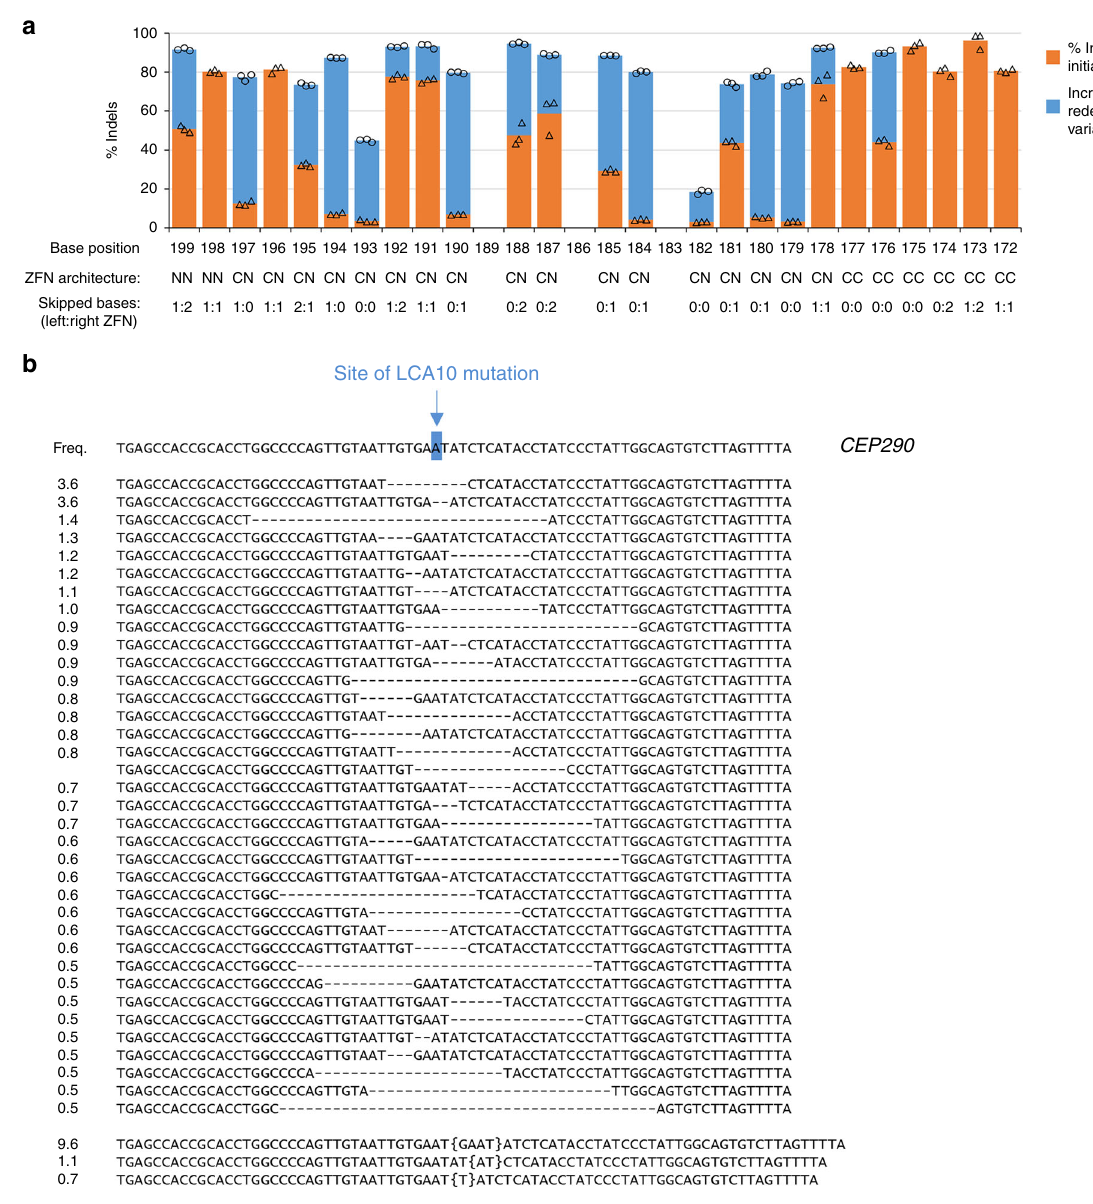
Fig. 4 Using new ZFN architectures for high-precision targeting. a Indel levels generated in a saturation scanning study of a 28 bp segment of the HBG1 promoter. ZFNs were designed to center cleavage on as many distinct base steps as possible for positions 172 – 199 upstream of the transcription start site (corresponding to the sequence 5 ′ -TTCCCCACACTATCTCAATGCAAATATC-3 ′ ). ZFN-encoding mRNA was delivered to K562 cells via nucleofection at a dose of 800 ng of mRNA per ZFN, followed by indel quanti fi cation via PCR of the target locus and deep sequencing (MiSeq). The x -axis indicates base position upstream of the transcription start, de fi ned as the center of cleavage between the two ZFN-binding sites. Details of each dimer are shown below the base position, indicating dimer architecture and the number of skipped bases in each ZFN. Results from the initial screen are shown as orange bars with individual data points provided as triangles, whereas blue extensions indicate the increase in modi fi cation observed with ZFNs developed via one additional cycle of design with individual data points provided as circles (e.g., for position 199, the initial designs yielded a dimer inducing 51% indels and the redesigned pair increased the modi fi cation by 41% to yield 92% indels). Each transfection was performed in triplicate. b Indel types and frequencies induced by a ZFN pair that straddles the site of the LCA10 mutation within the CEP290 gene. ZFNs were delivered as mRNA to K562 cells via nucleofection of 800 ng of mRNA per ZFN, followed by indel quanti fi cation via PCR of the target locus and deep sequencing (MiSeq). At the top of the alignment is the wild-type sequence of the target region in the CEP290 gene with the location of the LCA10 mutation highlighted in blue and indicated by the arrow. Below this are the deletion and integration events induced by ZFN treatment with frequencies > 0.5% (frequencies noted at the left). The total indel rate induced by this pair was 85% and in the aggregate the indels shown account for 51% of the total indels observed. Target sites for this ZFN are shown in Supplementary Fig. 18. The source data for this fi gure is available in the Source Data fi